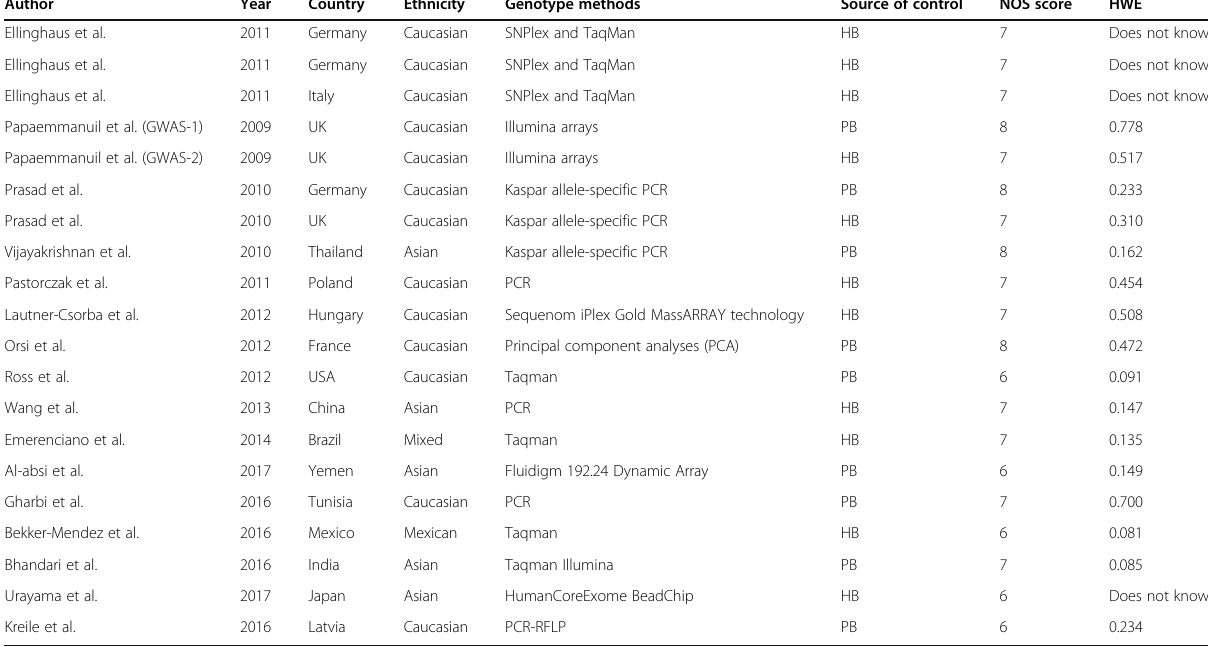
Table 1 Characteristic of studies included in the meta-analysis